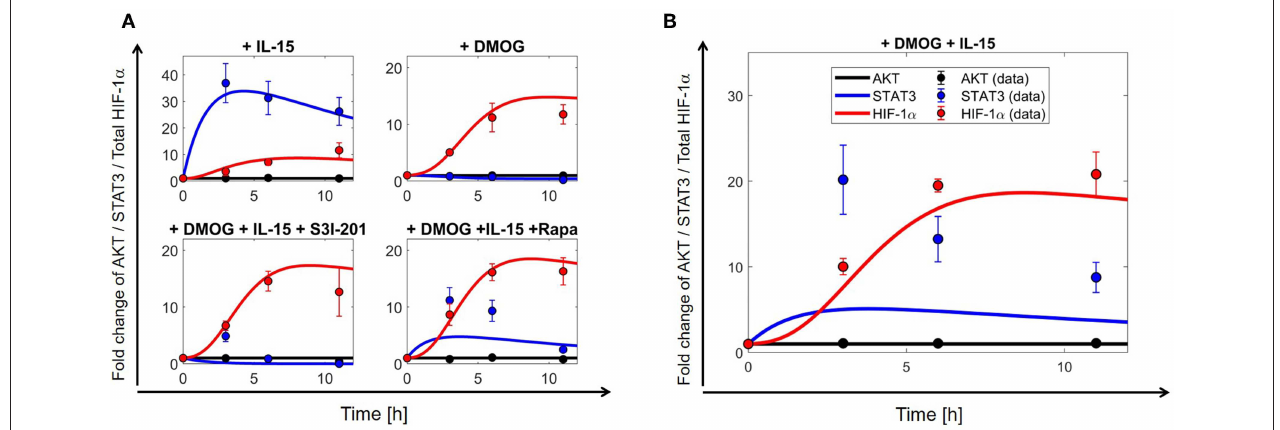
FIGURE 3 | The mathematical model (2)–(11) explains collected time series for HIF-1 α , STAT3, and AKT. Parameters used for numerical simulations are given in Tables 1 , 2 . (A) Model calibration results: comparison of numerical simulations (continuous curves) and collected experimental data (dots ± S.E.) of total HIF-1 α ( y 4 + y 6 + y 10 , red curves/dots), STAT3 (blue) and AKT (black). The model is fitted to data collected in different experimental settings: (upper left) IL-15-stimulated NK cells; (upper right) DMOG treated cells; (lower left) IL-15-stimulated NK cells treated with DMOG and STAT3 inhibitor (S3I-201); (lower right) IL-15-stimulated cells treated with DMOG and with mTOR inhibitor rapamycin (Rapa). (B) Model validation results: comparison of numerical simulations (continuous curves) and collected experimental data (dots ± S.E.) of total HIF-1 α ( y 4 + y 6 + y 10 , red curves/dots), STAT3 (blue), and AKT (black) for IL-15-stimulated cells treated with DMOG. Experimentally collected data points are reported in Table S2